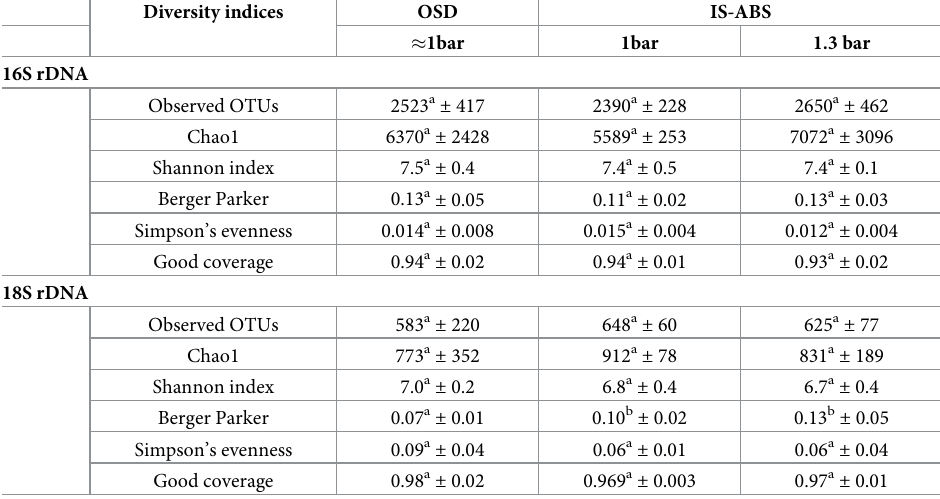
Table 2. Diversity indices for 16S and 18S rDNA. Calculated in the samples recovered using either the Ocean Sam- pling Day filtration standard procedure and the autonomous biosampler (IS-ABS) (mean ± standard deviation, n = 3). For IS-ABS two filtration pressures (1 and 1.3 bars) were used. Different superscript letters indicate significant (ANOVA, P < 0.05) differences among the three filtration procedures for each diversity